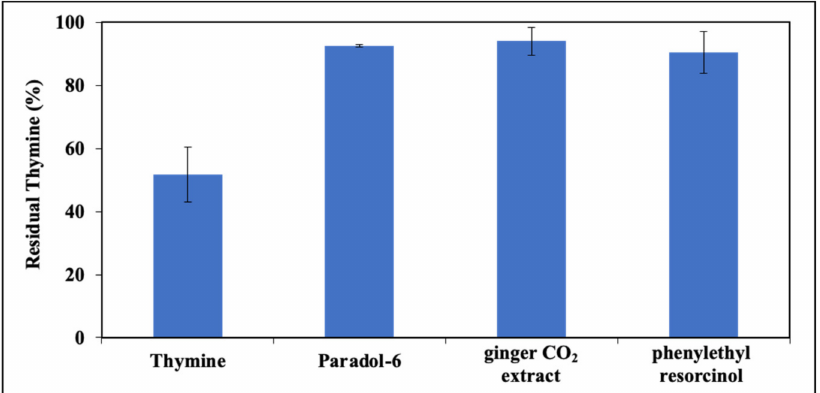
Figure 9. Residual thymine expressed as percent compared to control after photoirradiation at 254 nm at 3 h. Data are expressed as mean ± SD of three independent experiments, each performed in